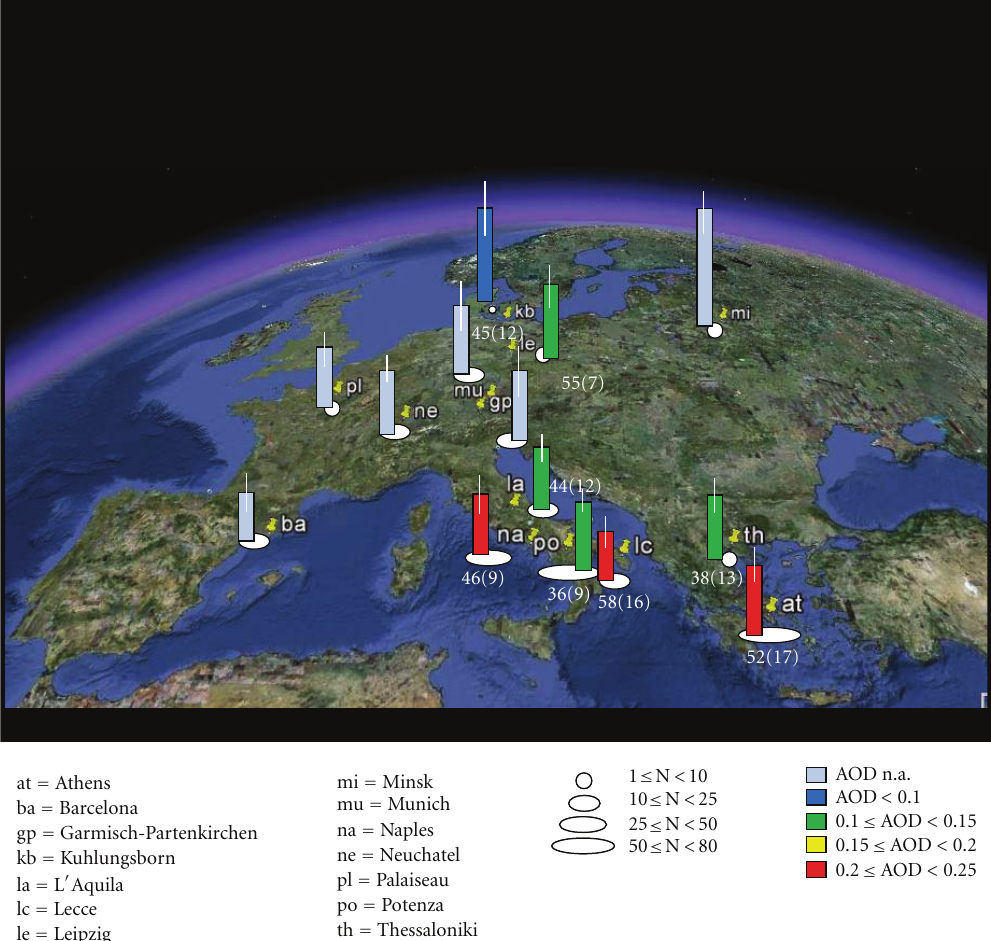
Figure 4: Main results of the 3-year climatological analysis performed within EARLINET [79]. For each station, the number of observed event ( N ) is reported following the code reported in the legend. The altitude of column bar represents the altitude of the dust layer center of mass and the white error bar its standard deviation. AOD at 355/351 nm is reported in di ff erent colors for di ff erent ranges of values. Finally, the mean S values at 355/351 nm calculated within the dust layer are reported in white followed by its standard deviation within